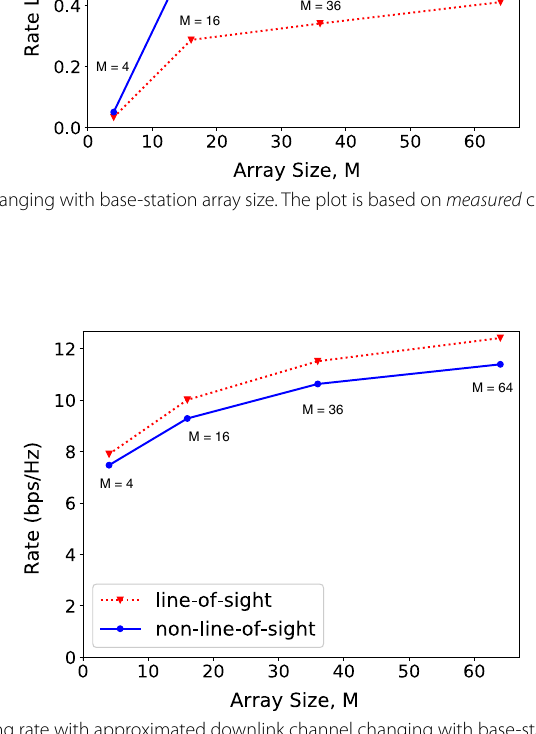
Fig. 11 Beamforming rate with approximated downlink channel changing with base-station array size. The plot is based on measured